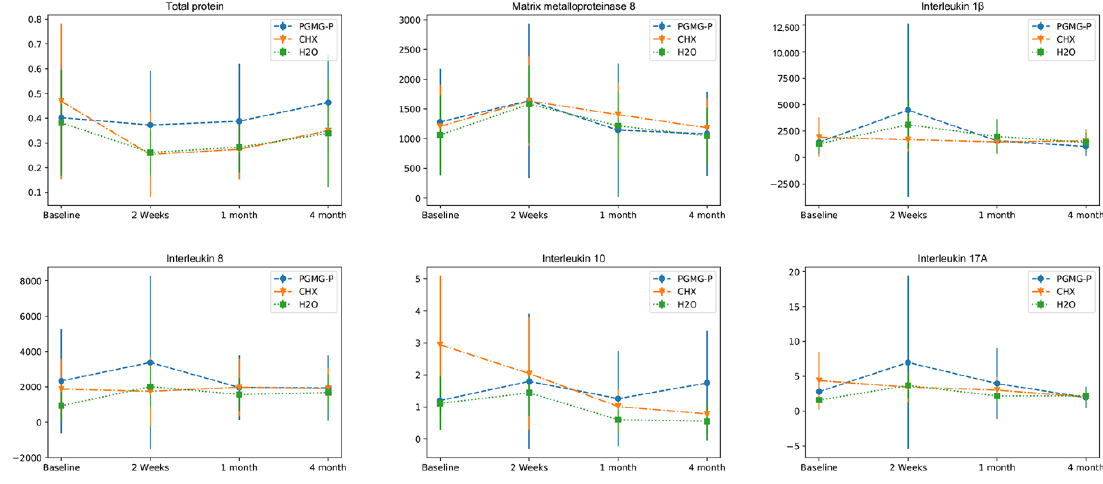
Figure 2. Dynamics of biomarkers in the course of the study.